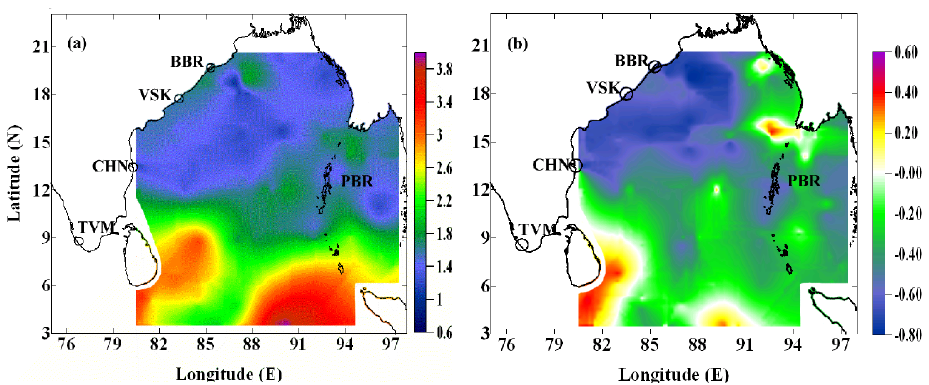
Fig. 12. Spatial distribution of WVC (a) and coefficient a 2 (b) over BoB during W-ICARB.